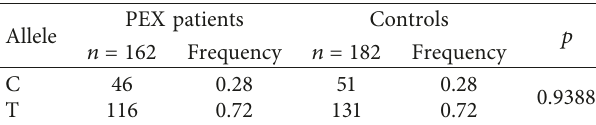
Table 1: Allele frequencies of rs3087554 polymorphisms in Polish population.